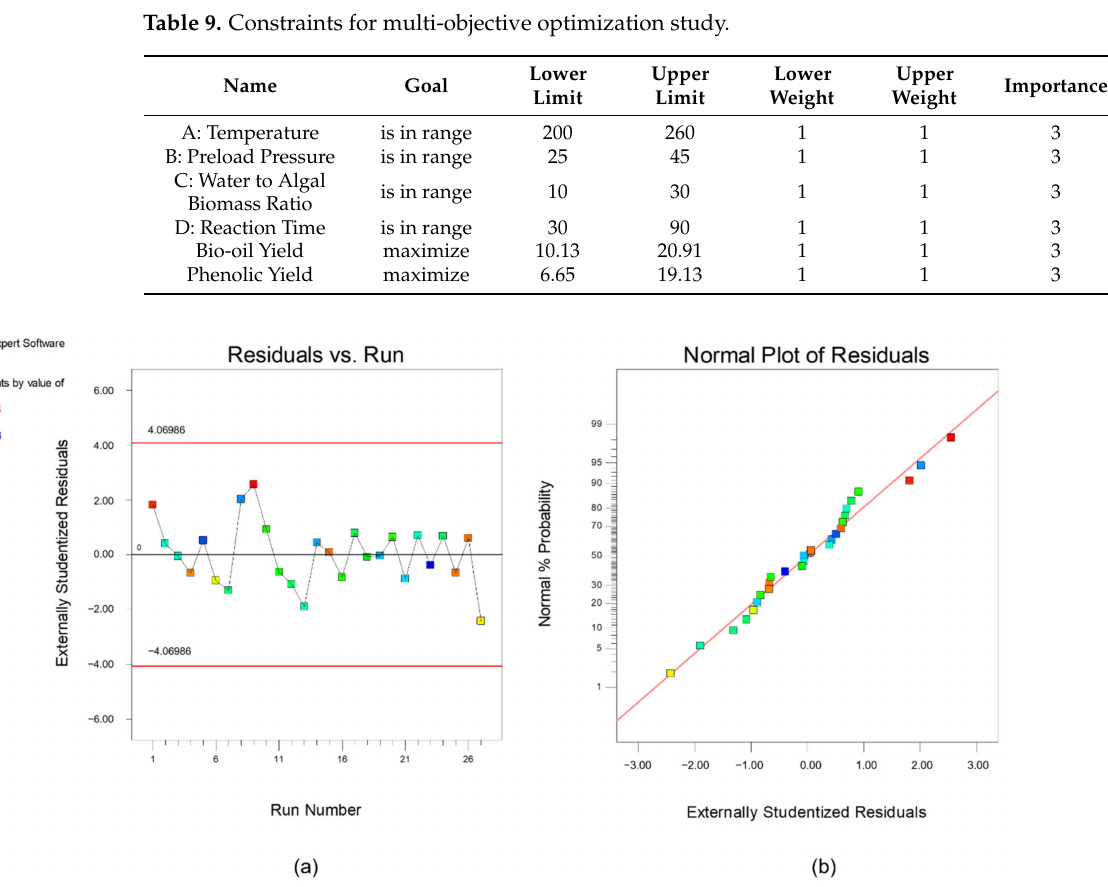
Figure 3. Diagnostic plot ( a ) residual versus experimental run and ( b ) normal plot of residuals for response, bio-oil